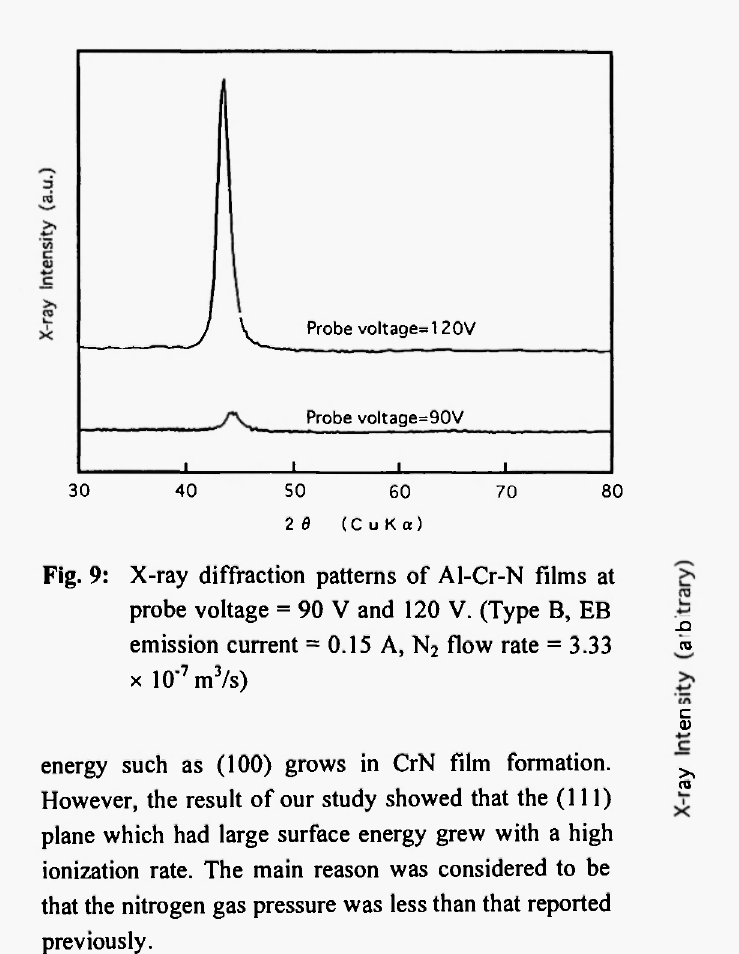
Fig. 9: X-ray diffraction patterns of Al-Cr-N films at probe voltage = 90 V and 120 V. (Type Β, EB emission current = 0.15 A, N 2 flow rate = 3.33 χ 10' 7 m 3 /s)